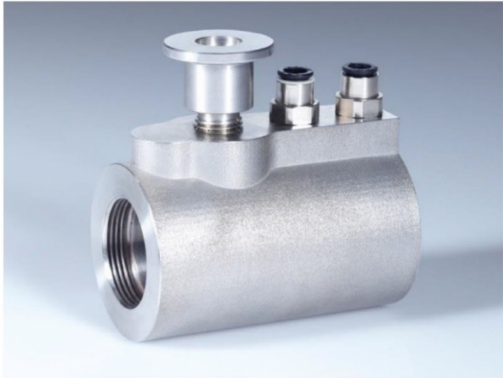
Figure 20. The calibration tool was made by L-PBF in 17-4PH